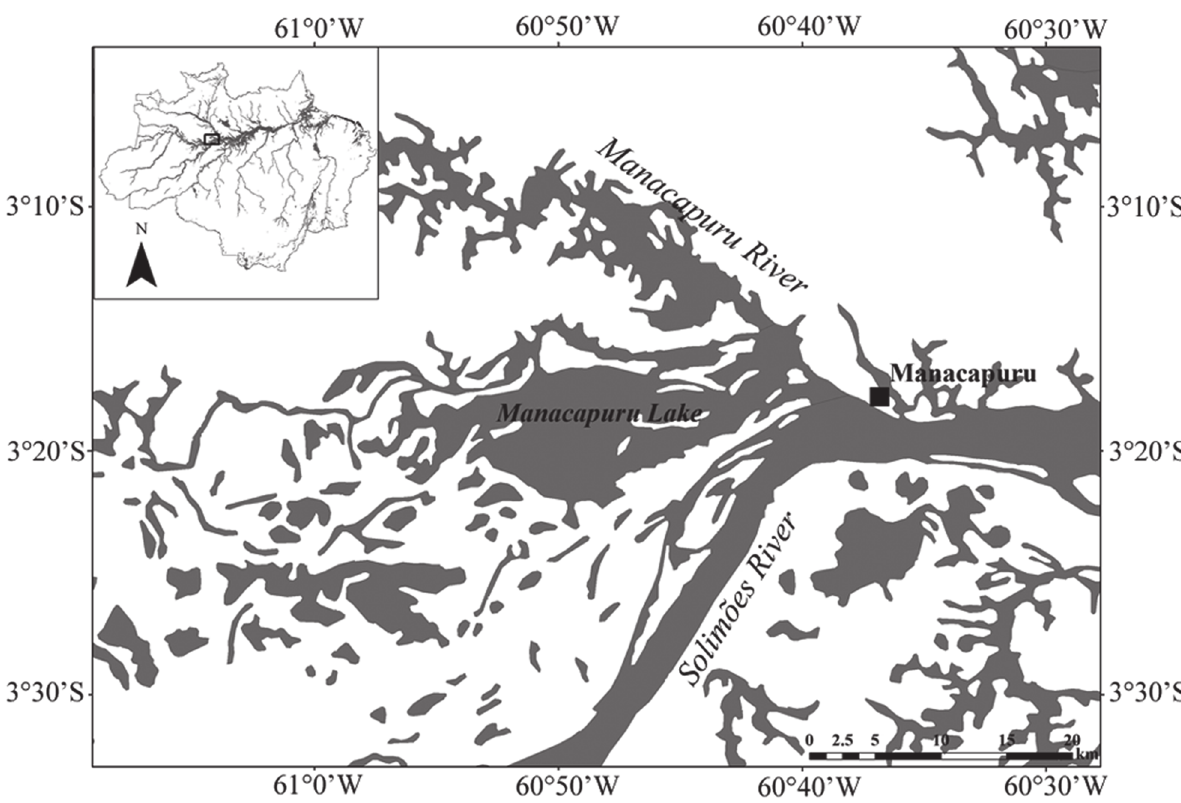
Fig. 1. Map of lago Grande de